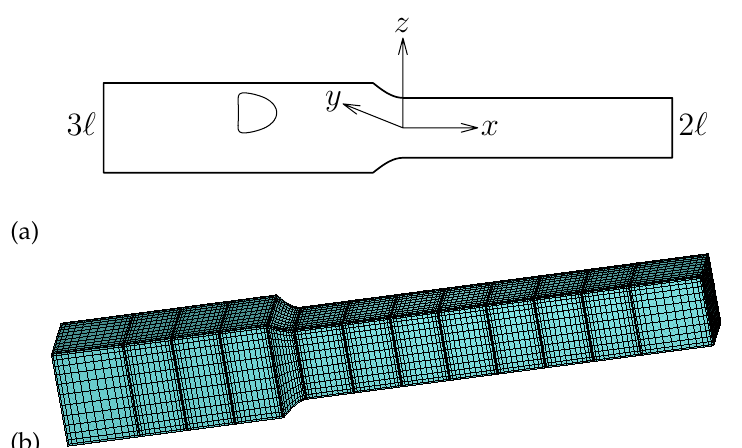
Figure 1. ( a ) Illustration of an elastic capsule flowing off the centerline of a converging square micro-channel. ( b ) Spectral boundary element discretization of the micro-capillary